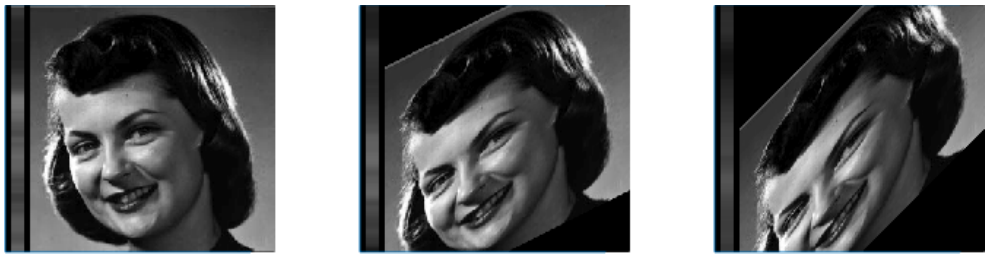
Figure 3. From left to right, an image sheared to accommodate, in a row, the discrete lines of central DRT for minimal, intermediate, and maximal slope of the 0 to 45 degrees quadrant.